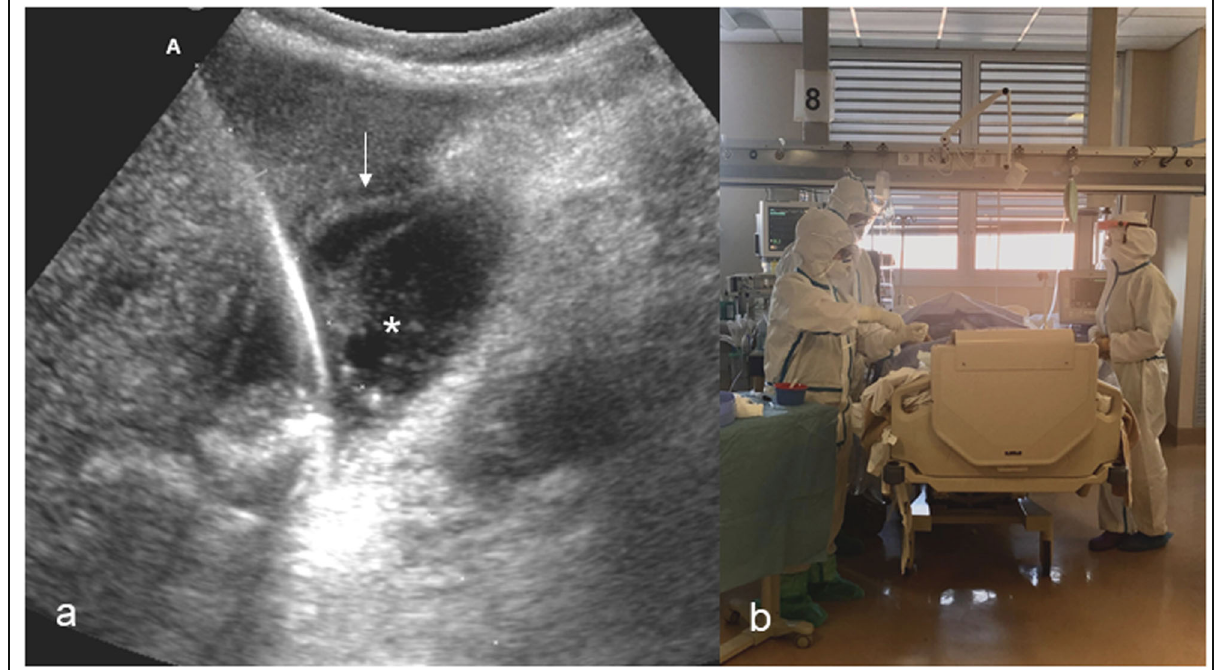
Fig. 1 Percutaneous transhepatic ultrasound-guided cholecystostomy through an intercostal approach in a coronavirus disease 2019, COVID-19, patient with acute cholecystitis. The guidewire (A), the “ railway sign ” of the gallbladder wall (arrow), and the presence of sludge and microlithiasis (asterisk) are shown in a . The interventional radiology team performing percutaneous gallbladder drainage at the bedside in intensive care unit is shown in